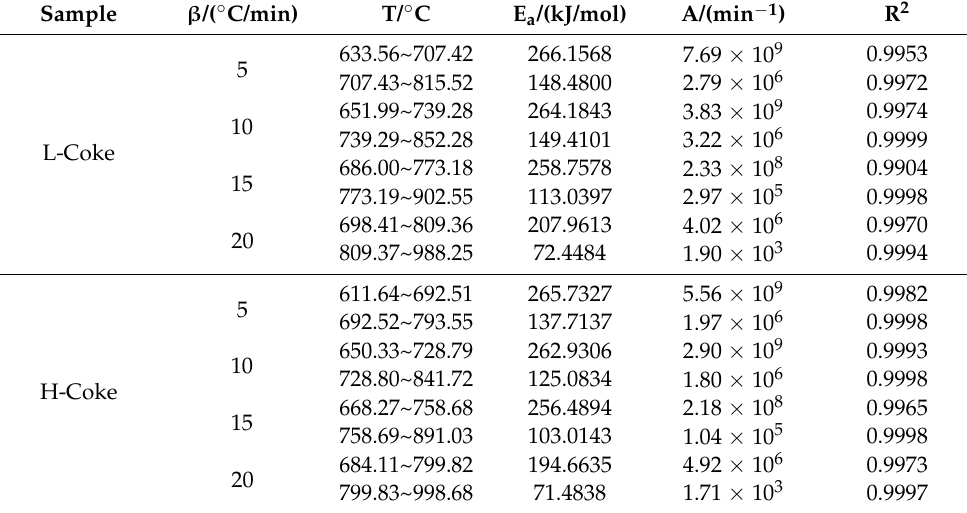
Table 4. Kinetic parameters of the coke calculated by the Coats–Redfern method.